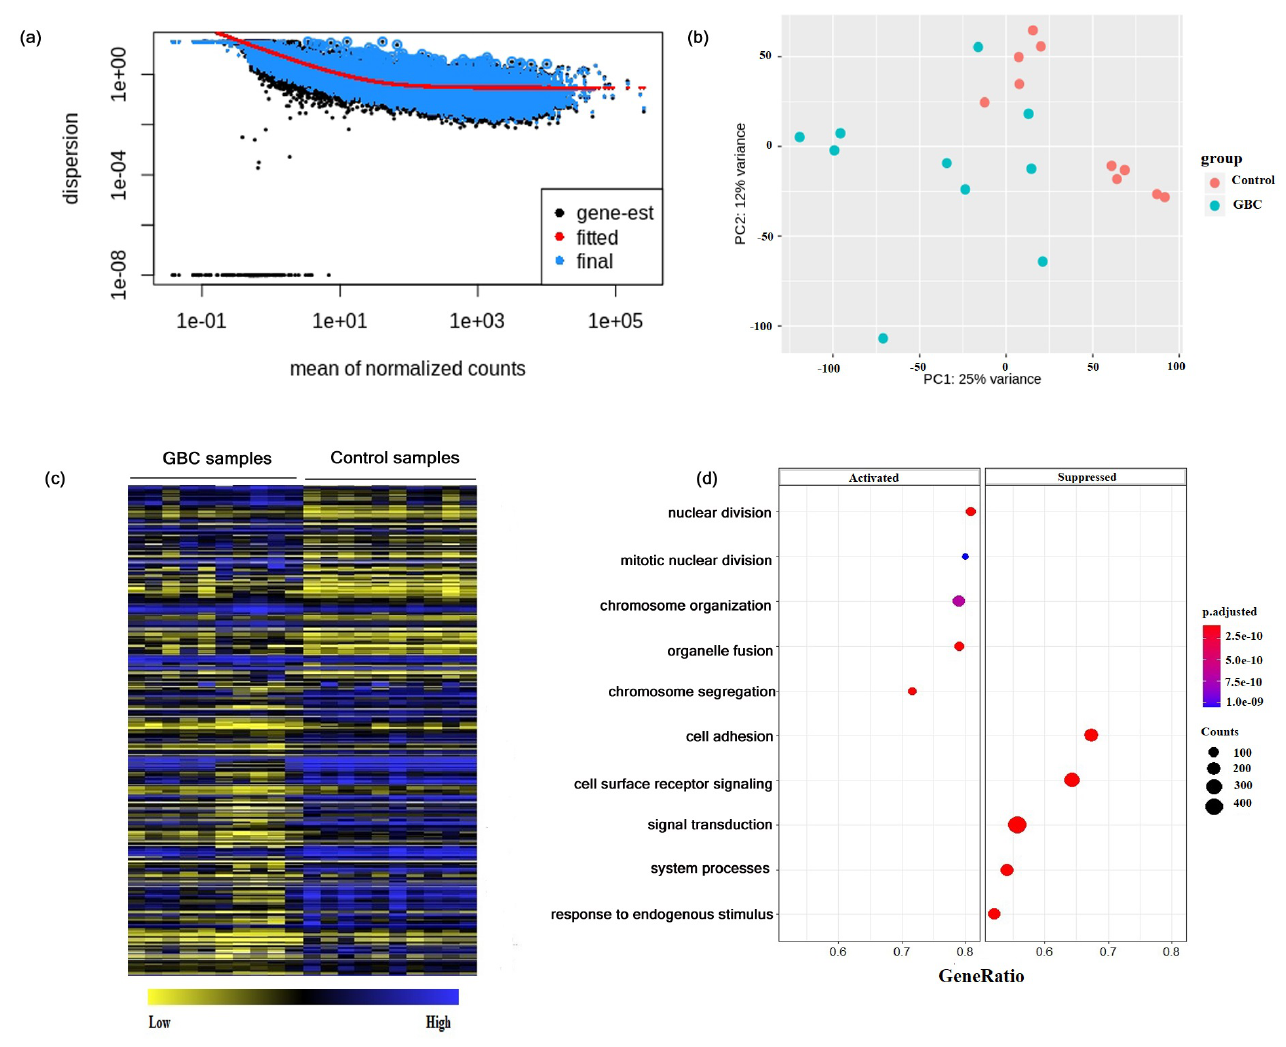
Figure 1. Differential gene expression in GBC. ( a ) An estimate of the dispersion plot for mean of normalized counts. ( b ) Principle component analysis of 10 GBC and 10 adjacent control samples. ( c ) Hierarchical clustering of top 100 significant DEGs in GBC compared to that of control. ( d ) Significant biological processes associated with